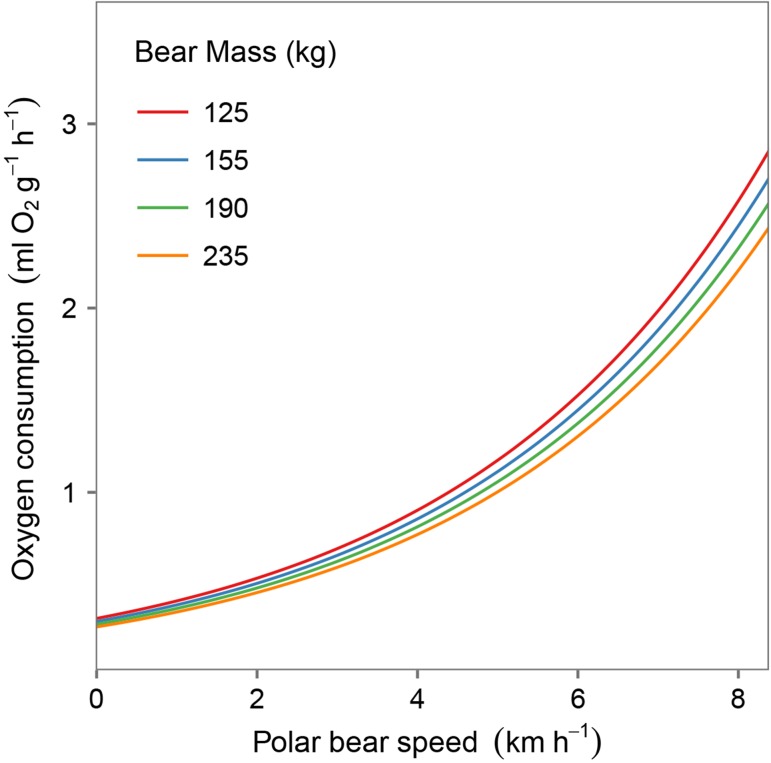
Mass-specific oxygen consumption (V˙O2) increases with movement speed. Postural costs (y-intercept) are affected by polar bear mass according to Equation 4. Larger bears are proportionately more efficient than smaller bears. Curves are based on predictions from the top model (exponential model; Equation 2), which when parameterized is: V˙O2 = (1.056 * mass−0.25) * e0.2626*S.